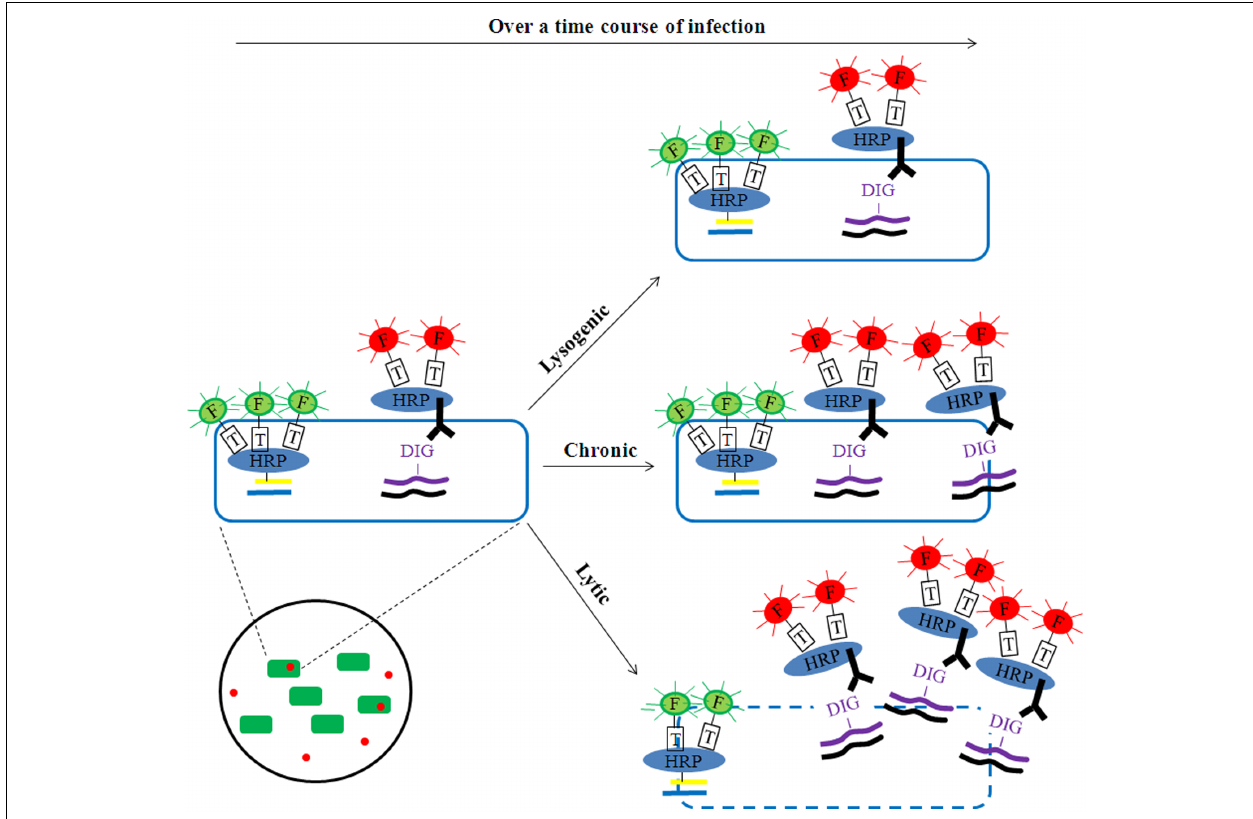
substantially for lytic infections and to a lesser extent for chronic infections. The bacterial signal (green) would decrease over time for lytic infection as a result of cell lysis and the release of phage progeny, while it should remain unchanged in chronic infections due to the production of progeny shredded out slowly without damaging cell membrane integrity. In this way the dual-labeling signals can help discriminate three modes of phage infection at the single-cell